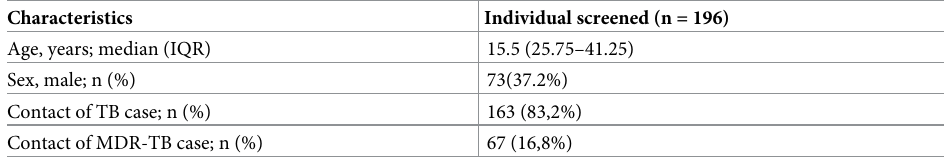
Table 1. Characteristics of study